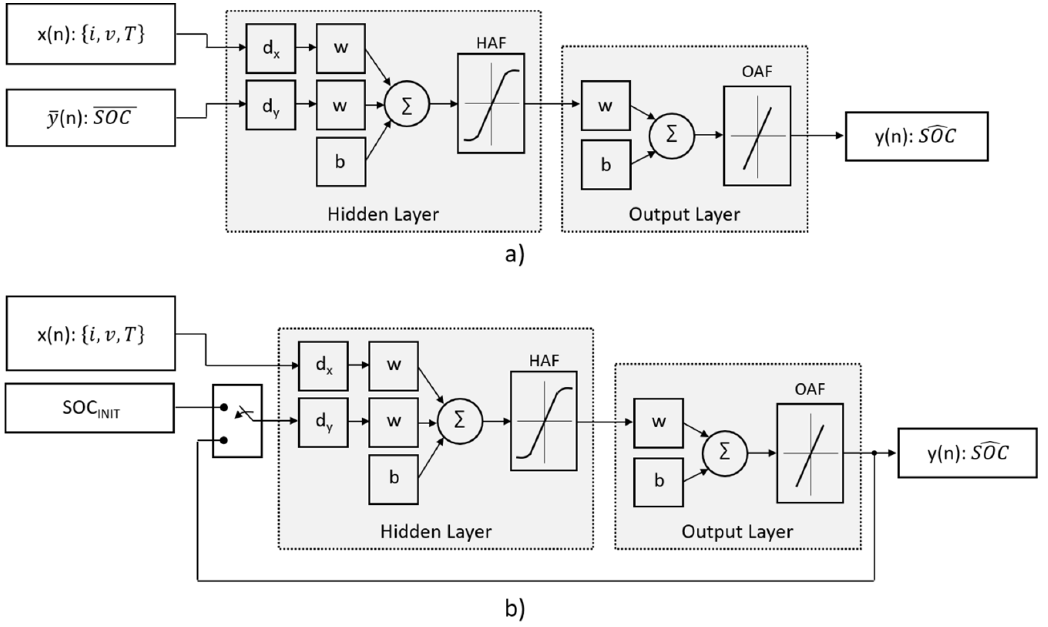
Figure 2. Nonlinear autoregressive neural network with exogenous input (NARX) architecture. ( a ) Series–parallel (SP) mode (open-loop configuration) adopted during the training. ( b ) Parallel (P) mode (closed-loop configuration) adopted for the estimation when the network is